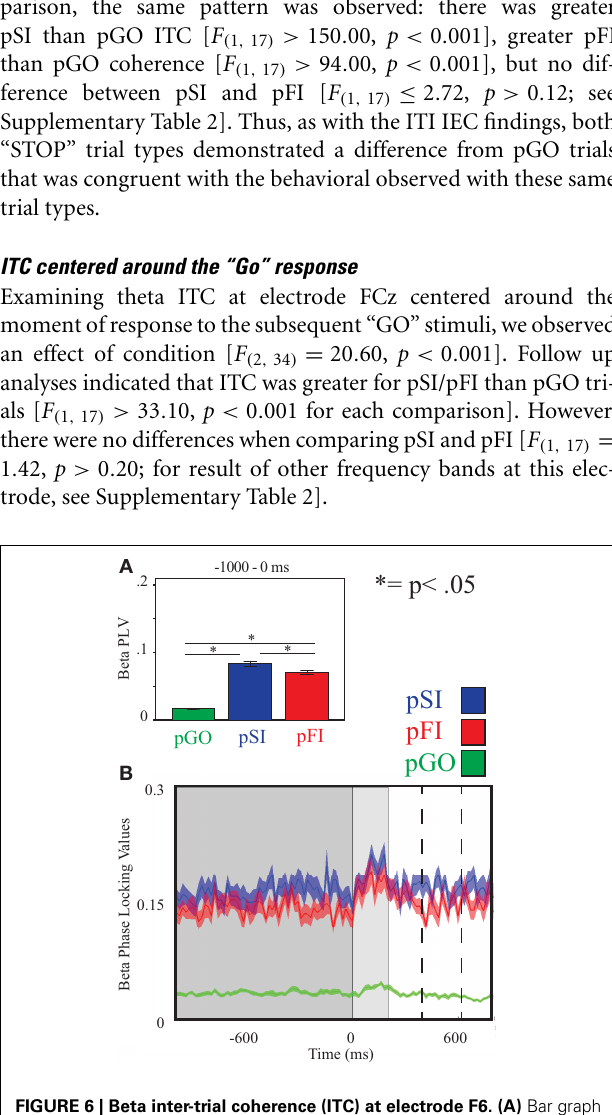
FIGURE 6 | Beta inter-trial coherence (ITC) at electrode F6. (A) Bar graph displaying mean ITC averaged over the − 1000 to 0ms interval, with 0ms as GO stimulus onset. (B) Line plot illustrating ITC from − 1000 to + 1000ms, with the dark gray highlighting the ITI, the light gray bar after 0ms highlights maximal coherence following stimulus onset, and the dashed lines indicating ITC centered around the “Go”